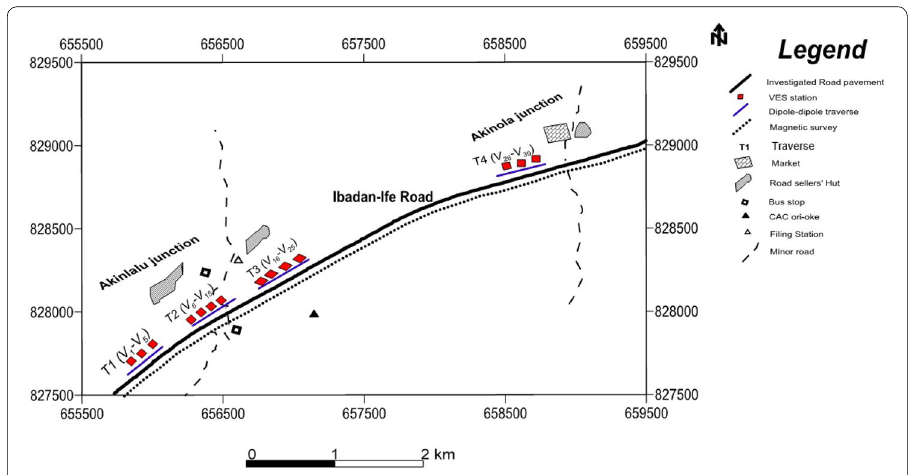
Fig. 3 Location and data acquisition map of the Study